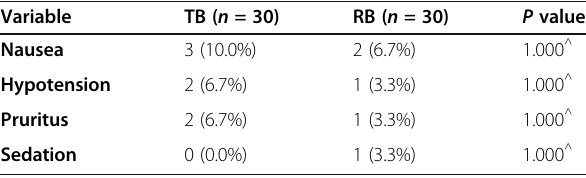
Table 3 Postoperative complications among the study groups Variable TB ( n = 30) RB ( n = 30) P value Nausea 3 (10.0%) 2 (6.7%) 1.000 ^ Hypotension 2 (6.7%) 1 (3.3%) 1.000 ^ Pruritus 2 (6.7%)